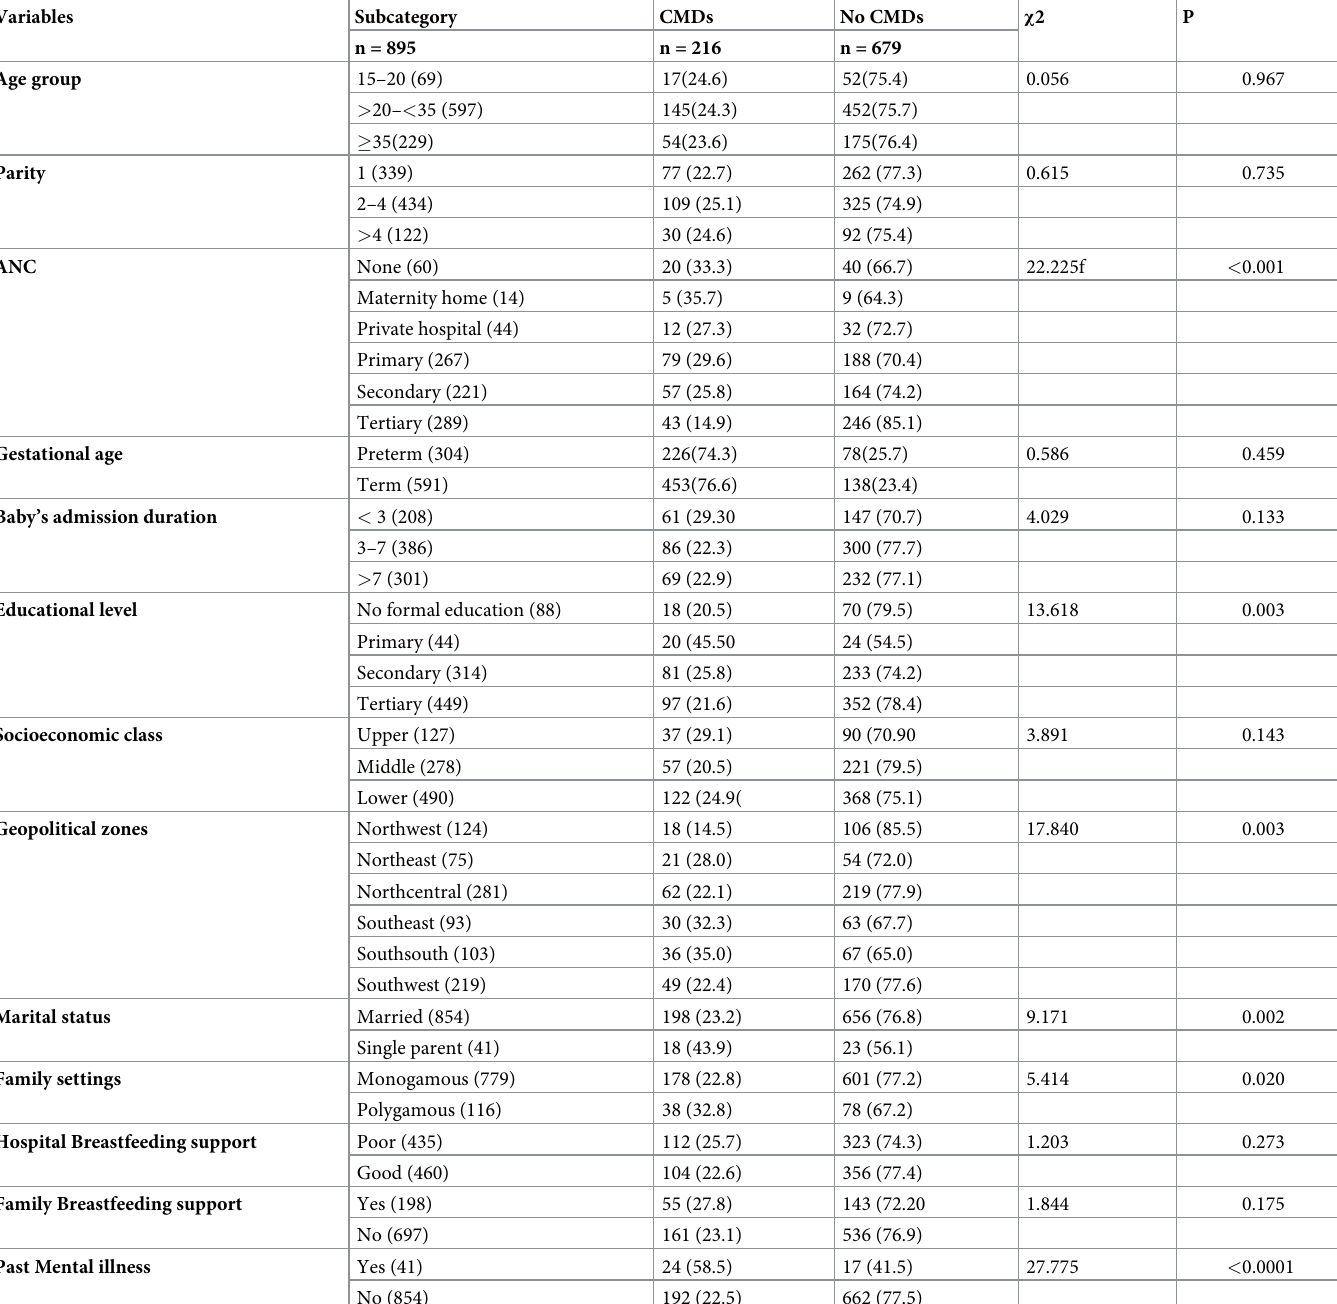
Table 2. Factors associated with common mental disorders